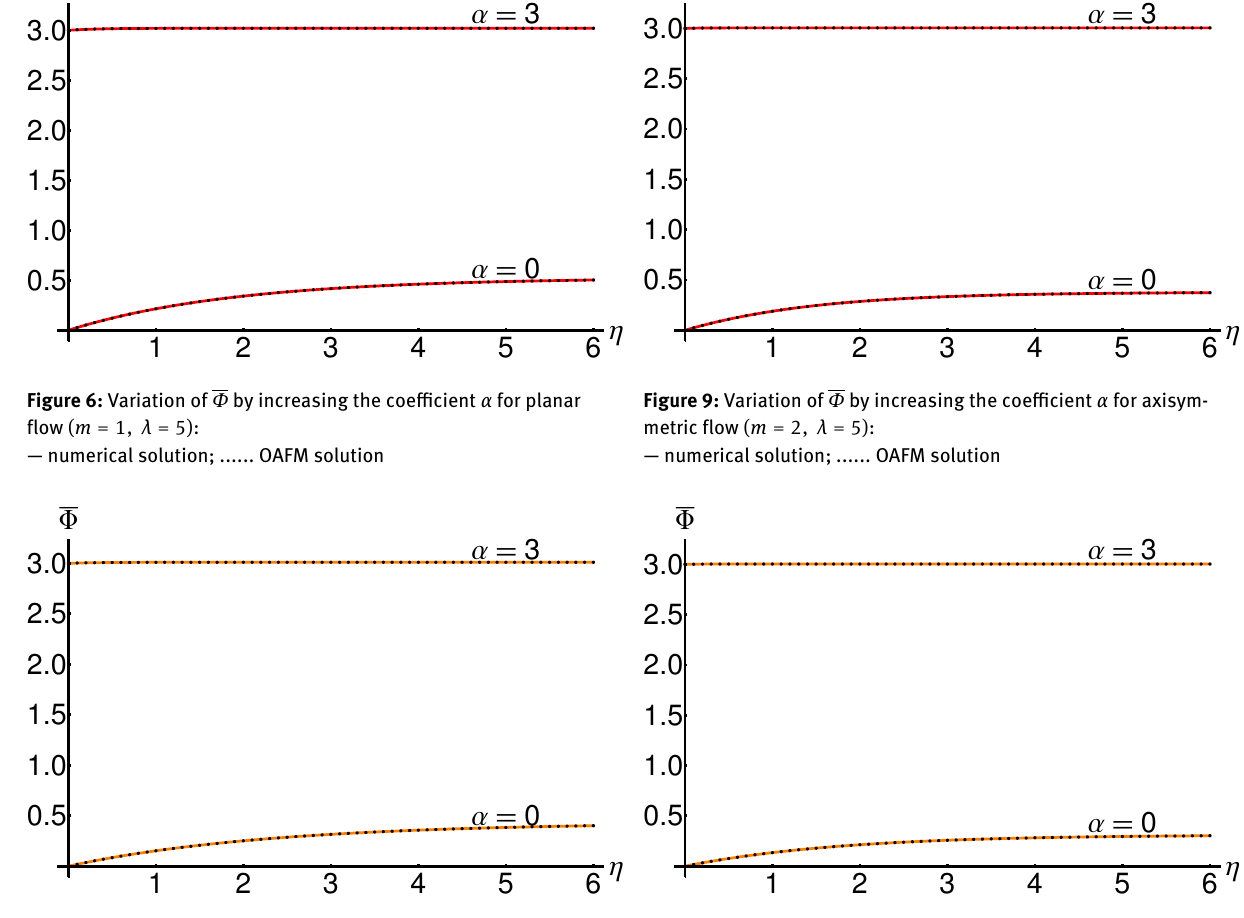
Figure 7: Variation of Φ by increasing the coeflcient α for planar flow ( m = 1, λ = 10) : — numerical solution; ...... OAFM solution